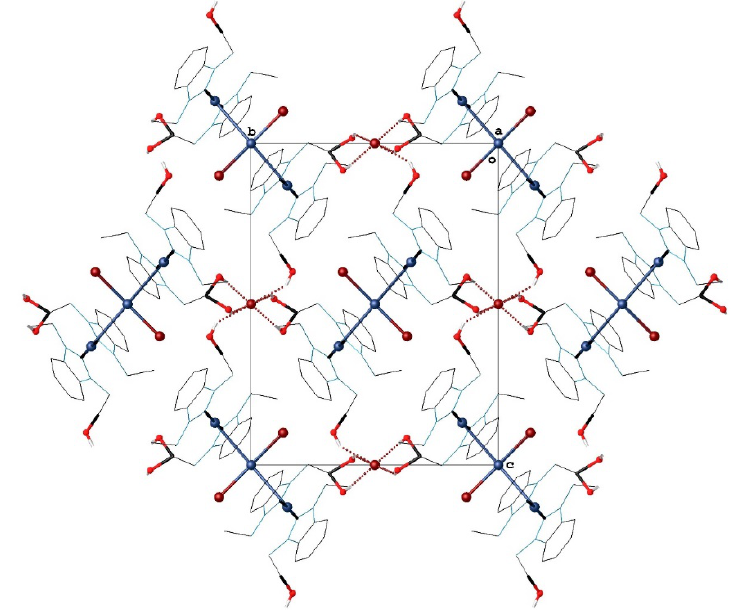
Figure 6. Representation of the packing diagram for the Ag-NHC complex 1 . The Ag2 atoms settle in each corner of the unit cell and one is in the middle, while the bromide anions are between these corner silver atoms. The Ag, Br and O atoms are shown as balls, while the other atoms are shown in a wireframe style. For the sake of clarity, hydrogen atoms that do not to play role in the bonding are omitted.